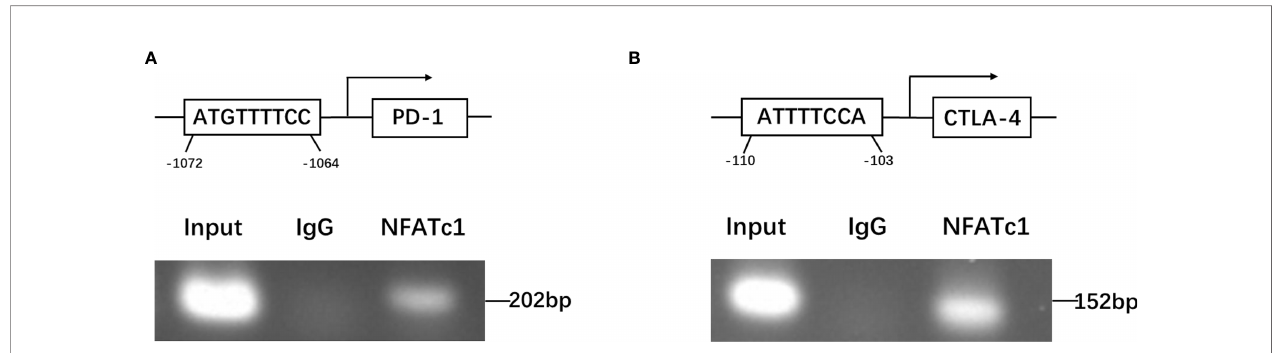
FIGURE 6 | NFATc1 directly targets the promoter regions of the PD-1 and CTLA-4 genes. (A) ChIP assay was used to detect the binding of NFATc1 to the promoter region of the PD-1 gene. (B) ChIP assay was used to detect the binding of NFATc1 to the promoter region of the CTLA-4